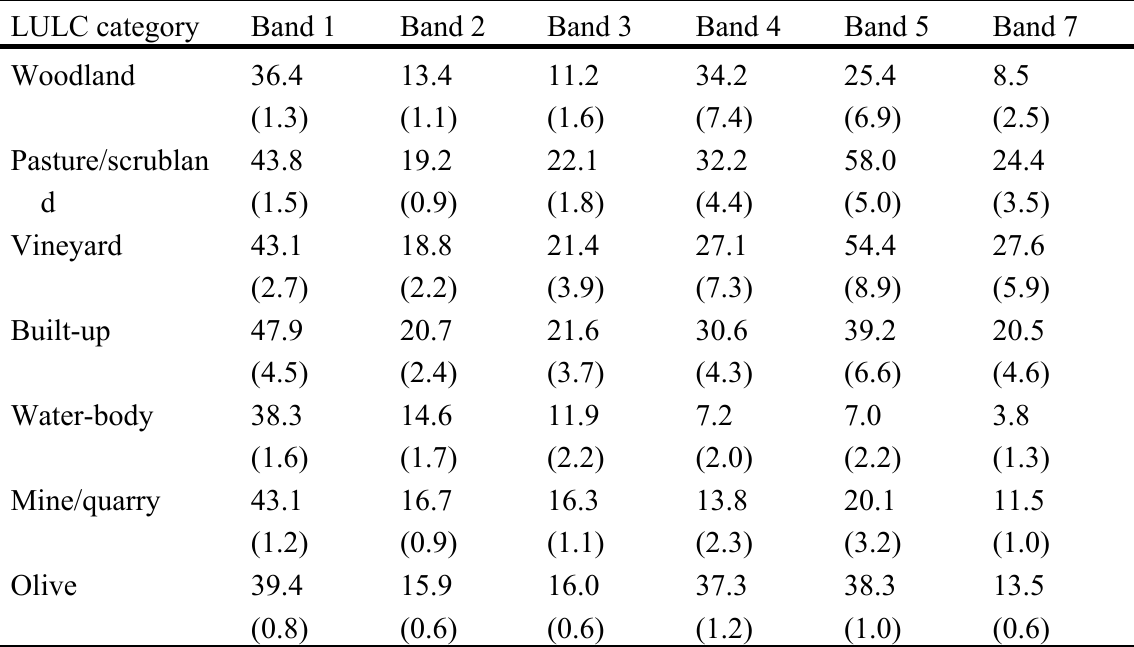
Table 2. The mean DN values of the training pixels of different LULC categories used for the maximum likelihood classification; values in bracket are the standard